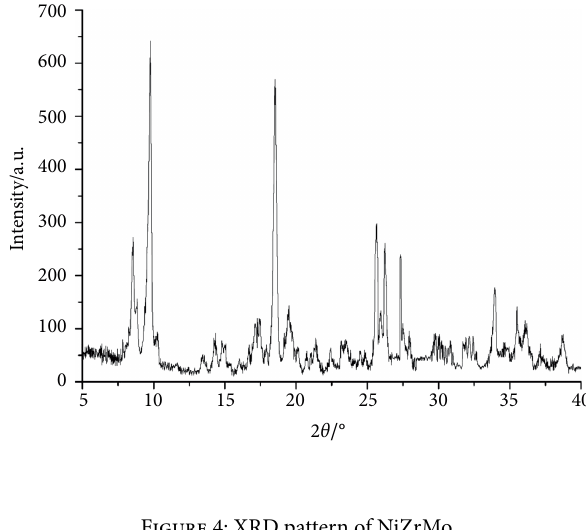
Figure 4: XRD pattern of NiZrMo.